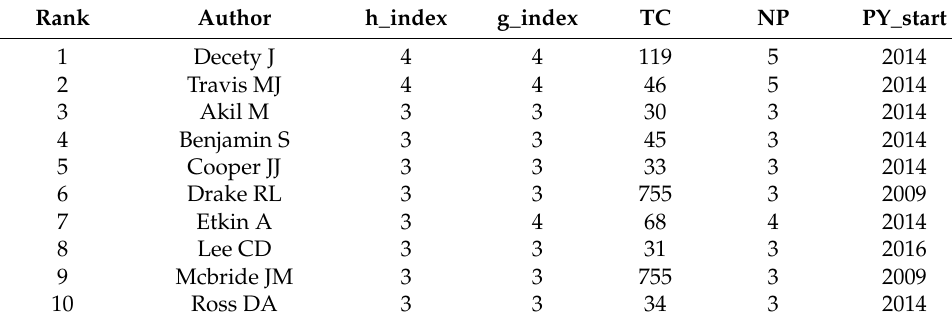
Table 5. Top 10 most influential